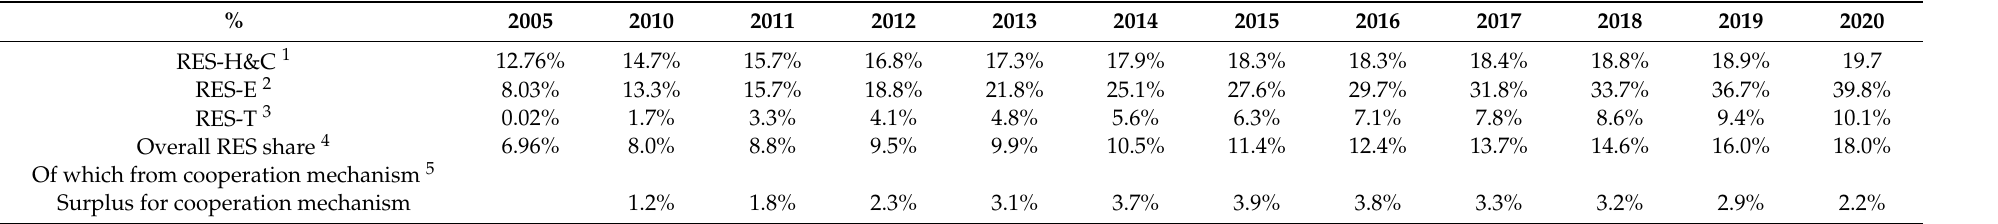
Table 6. Greece’s target and estimated trajectories in heating/cooling, transport, and electricity